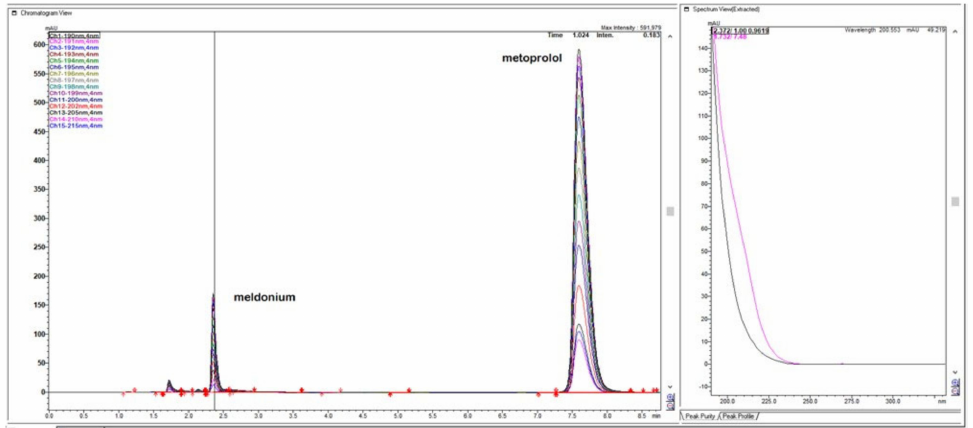
Figure 9. Multi 15-channel chromatogram 250 × 4 mm LiCnrospher 100 CN with 20% ACN -13 mM NH 4 H 2 PO 4 . The two extracted peaks were from first eluted not-integrated small peak with tR about 1.7, with the characteristic meldonium concave Abs